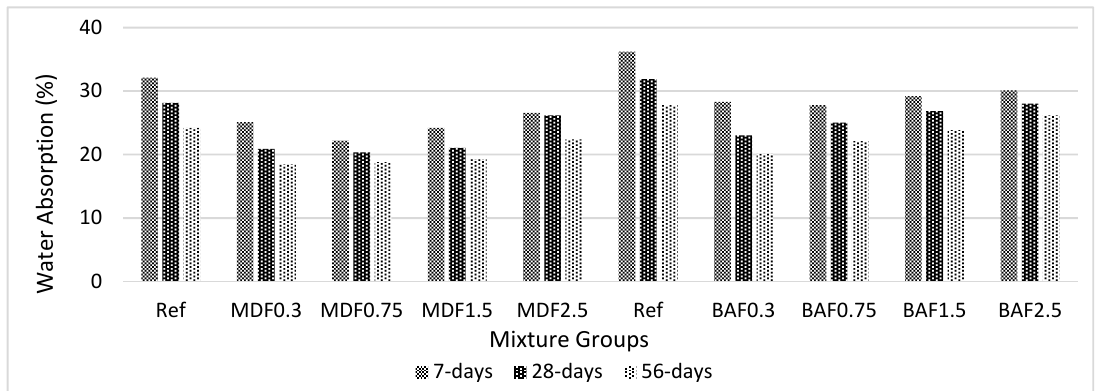
Figure 6. Effect of carbon fiber on water absorption for marble and bottom ash mixture groups at 7, 28, and 56 days of curing.